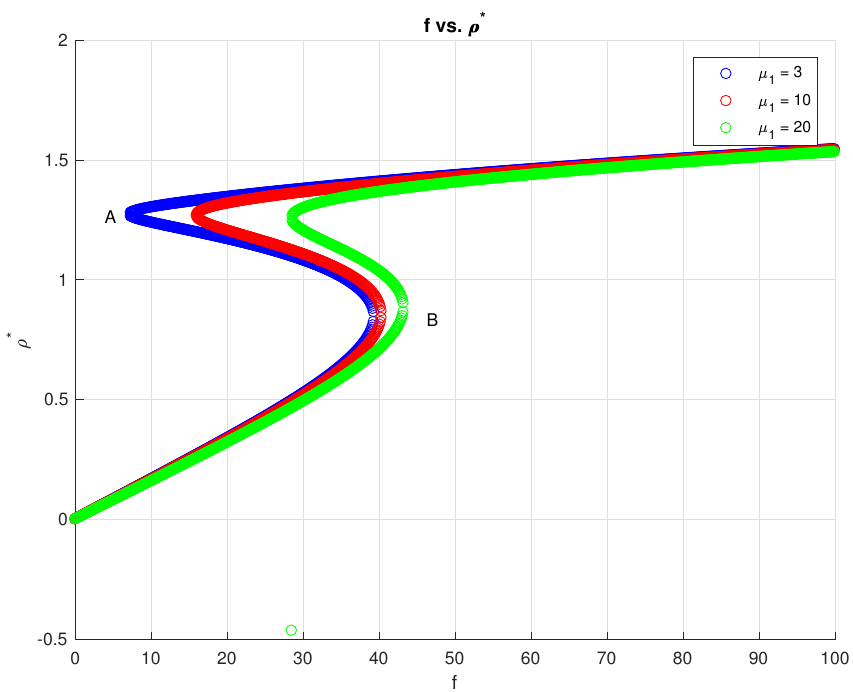
Figure 3. External Excitation Response Curve ( µ 1 = 4,15,25 and α 1 = 0.2, α 3 = 1.5, α 5 = 2, σ = 30, k = 1 and m 21 = 0.7).